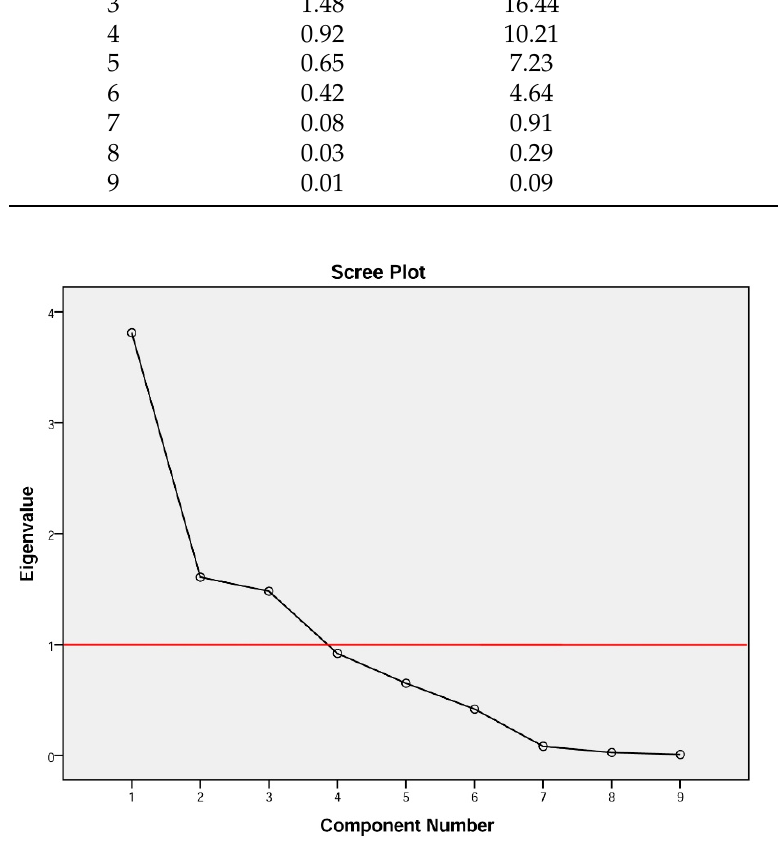
Figure 5. The eigenvalue versus the number of factors (The black line represents the eigenvalues of each factor and the red one shows the eigenvalues equal to or greater than 1). Table 6. Eigenvalue and percentage of data explained by each